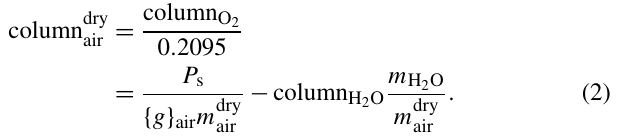
(middle), and X C (bottom). 4 2 H 6 in line with 4 2 H 6